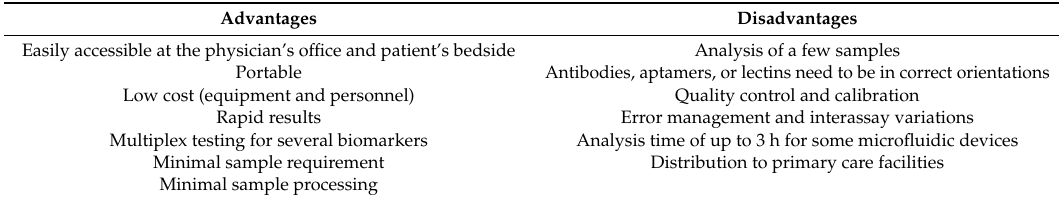
Table 3. Advantages and disadvantages of point-of-care